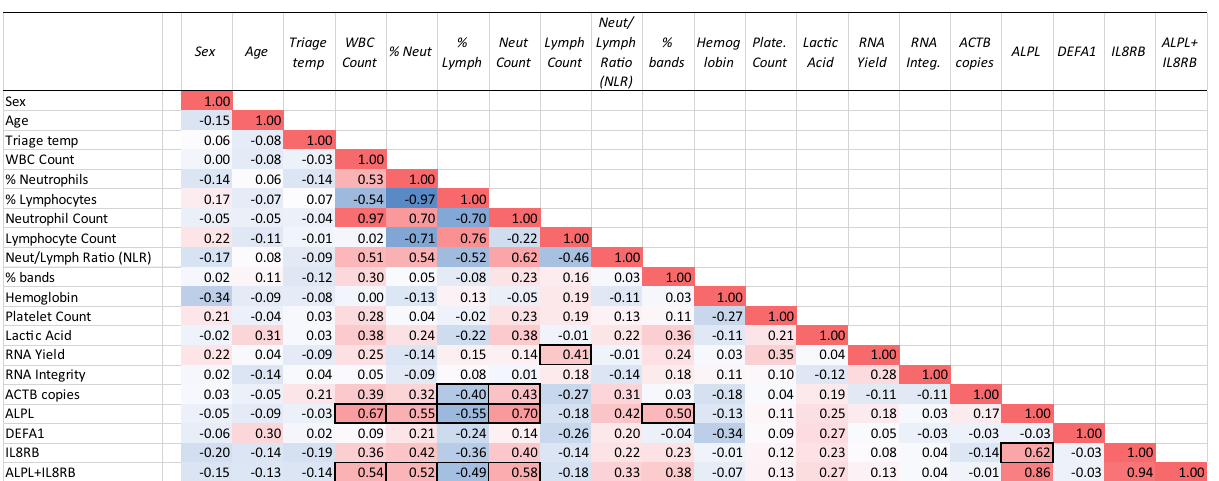
Figure 2. Correlation of clinical factors and biomarkers. Across all patients, regardless of clinical diagnosis, the relationship between the measured variables was explored by a correlational analysis to examine covariate trends. Correlations were calculated by the Pearson correlation coefficient (r), which is a measure of any linear association between two variables. Negative trends are highlighted in blue, and positive trends are highlighted in red. The value of r ranges between − 1 and